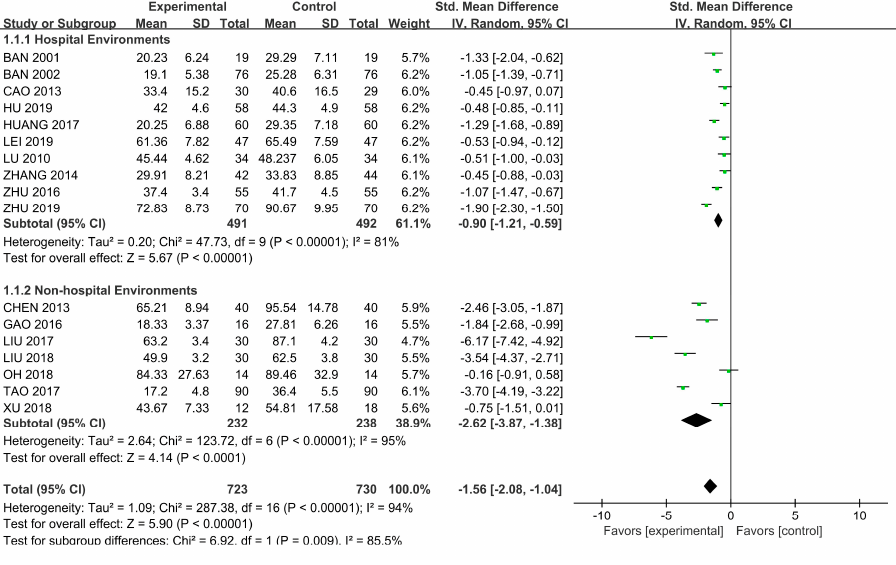
Figure 4. Effects on the symptoms.